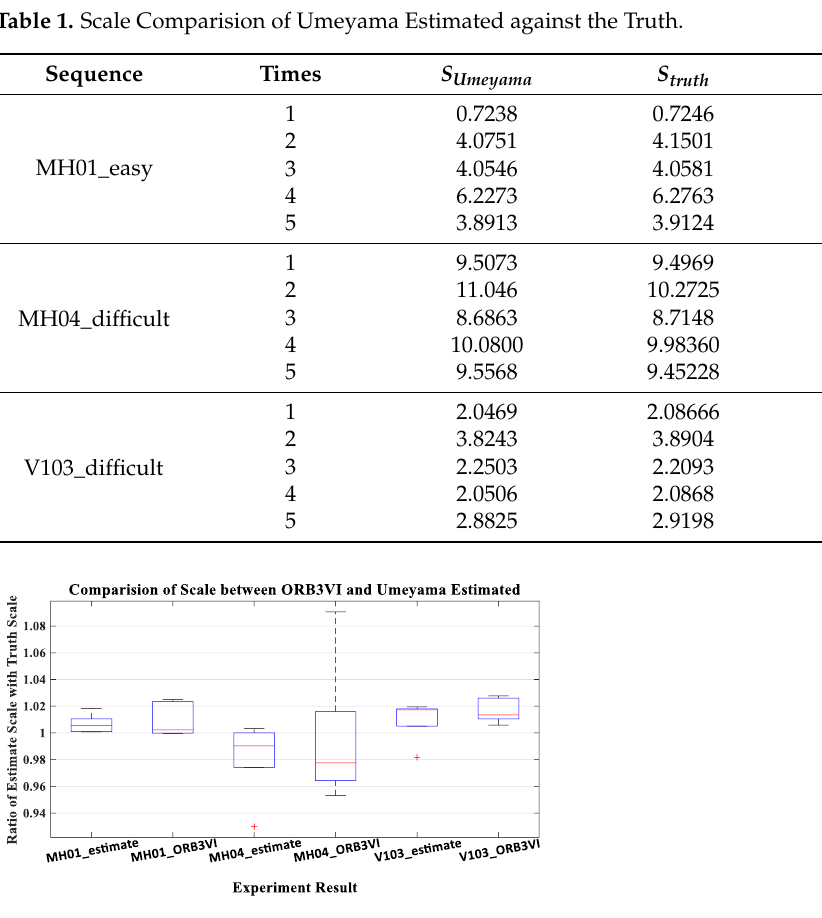
Figure 7. The distribution of ratio value in five times experiments. The experiments are carried out in MH_01_easy, MH_04_difficult, and V1_03_difficult sequences. The XX_estimate represents the ratio estimated by Umeyama algorithm, and the XX_ORB3VI represents the ratio obtained by ORB-SLAM3 in monocular-inertial mode.